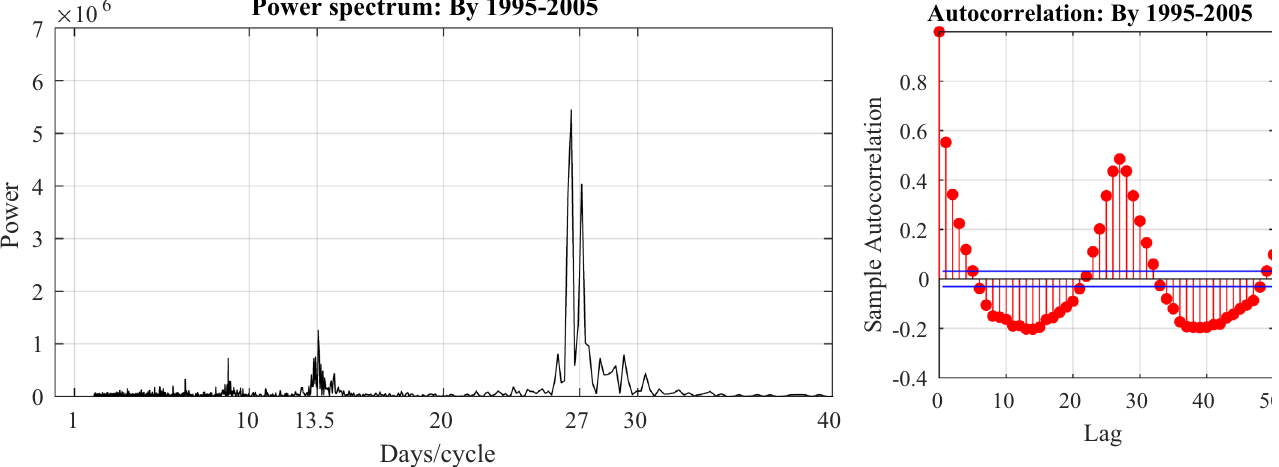
Fig. 8. Left panel : Power spectrum of the IMF B y -index in the time period 1995 – 2005. Right panel : Autocorrelation function of the IMF B y -index in the time period 1995 – 2005. The blue lines show the 95% con fi dence bounds of the autocorrelation